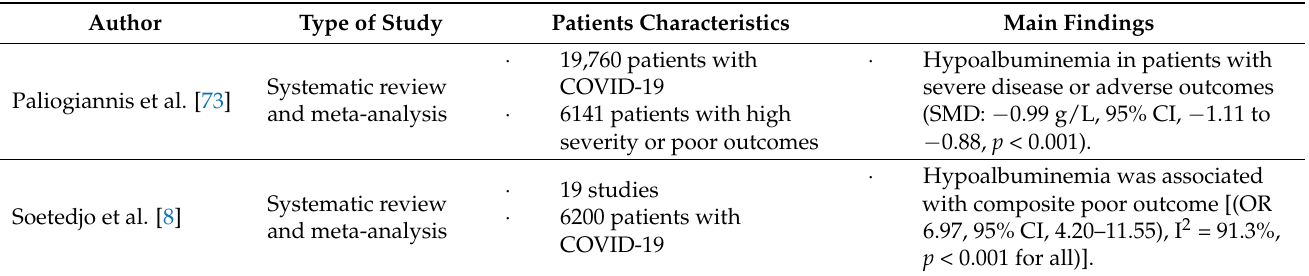
Table 1. COVID-19 Prognosis and Serum Albumin